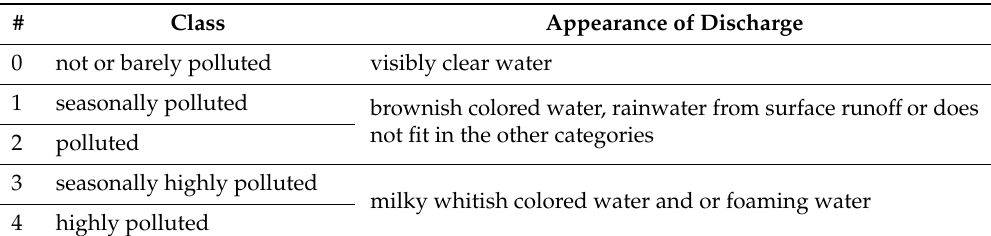
Table 1. Classification of water quality; Author’s